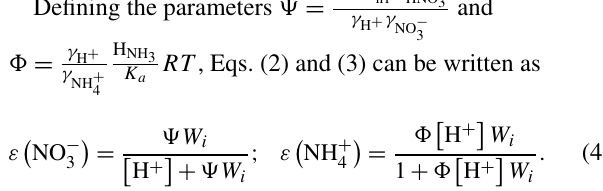
) (blue 3 ) (red curve), versus pH for 4 ∂ NO − ≈ 1) to the amount of total 3 ∂ NO T 3 ∂ NH + ∼ 1), purple is 4 ∂ NH T 3